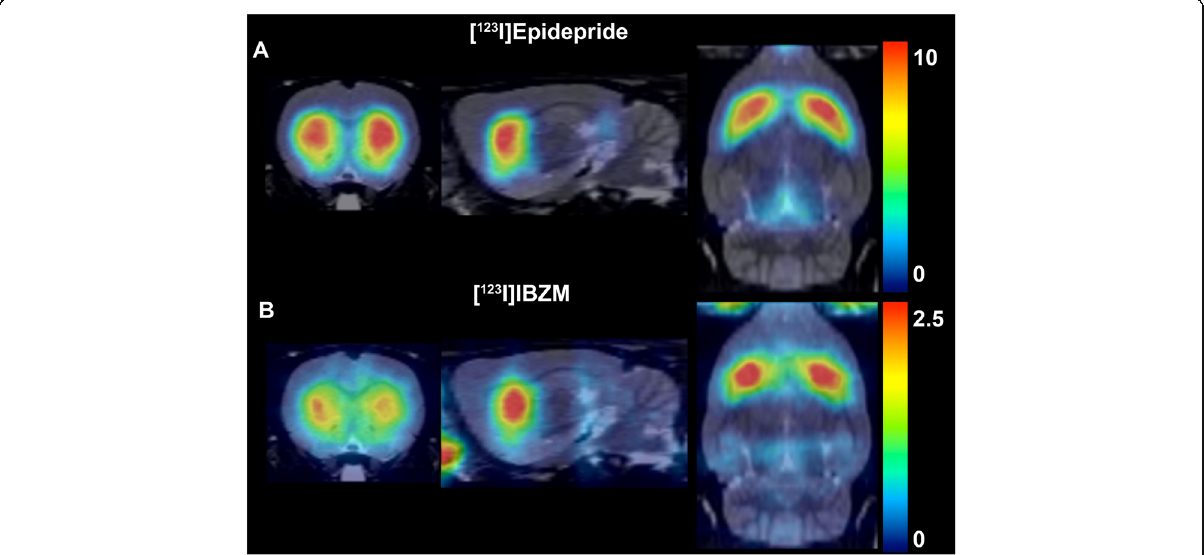
Fig. 9 A SPECT image (coronal, sagittal, and axial planes) obtained with a [ 123 I]epidepride and b [ 123 I]IBZM. The color scale is in KBq/ml. Note the superior quality of the image obtained from the [ 123 I]epidepride experiment in terms of a better anatomical delineation of the striatum and the highest binding of the radiotracer (the color scale of the [ 123 I]epidepride image ranges from 0 – 10 KBq/ml, while the [ 123 I]IBZM image ranges have a much lower binding, ranging from 0 – 2.5